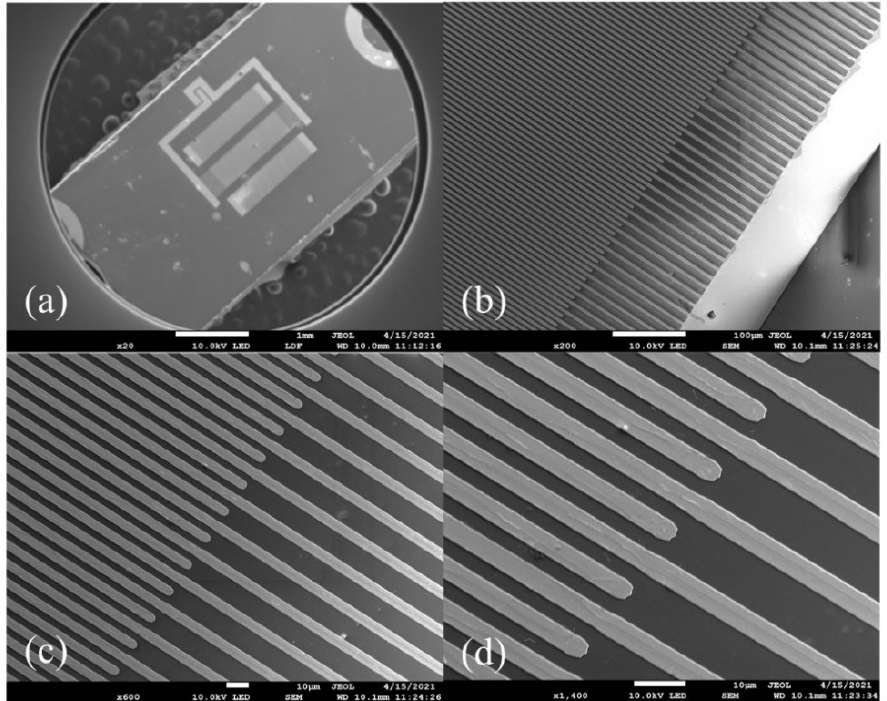
Figure 2. ( a ) SEM image of SAW resonator, ( b ) 200 times, ( c ) 600 times, and ( d ) 1400 times magnification of IDTs structure with a width of 4 μm.